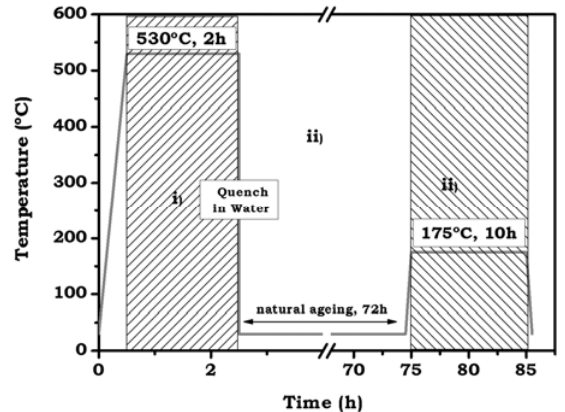
Figure 2. Temperature program followed during the heat